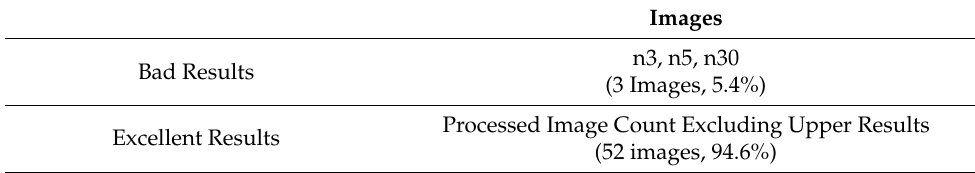
Table 11. Summary of non-crack